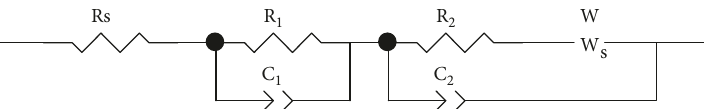
Figure 6: Equivalent circuit used to fi t EIS